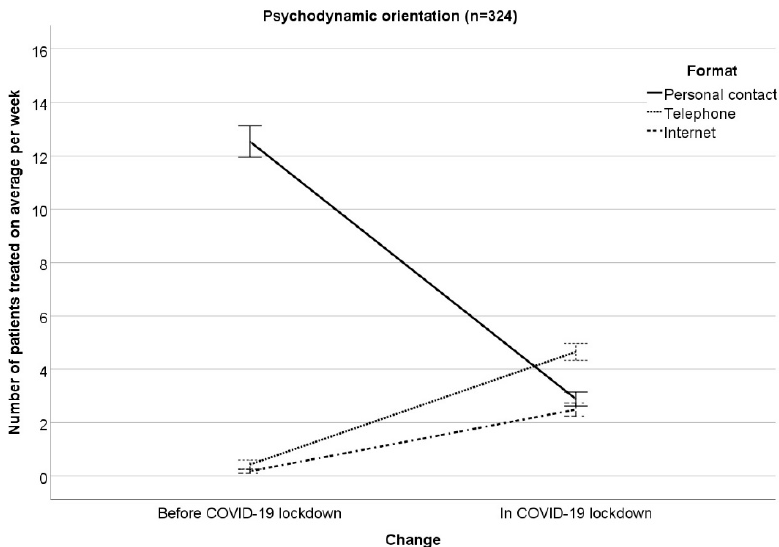
Figure 1. Patients treated on average per week in personal contact, via telephone, via Internet in the months before/in COVID-19 lockdown for psychodynamic orientation. Mean ± 1 standard error.